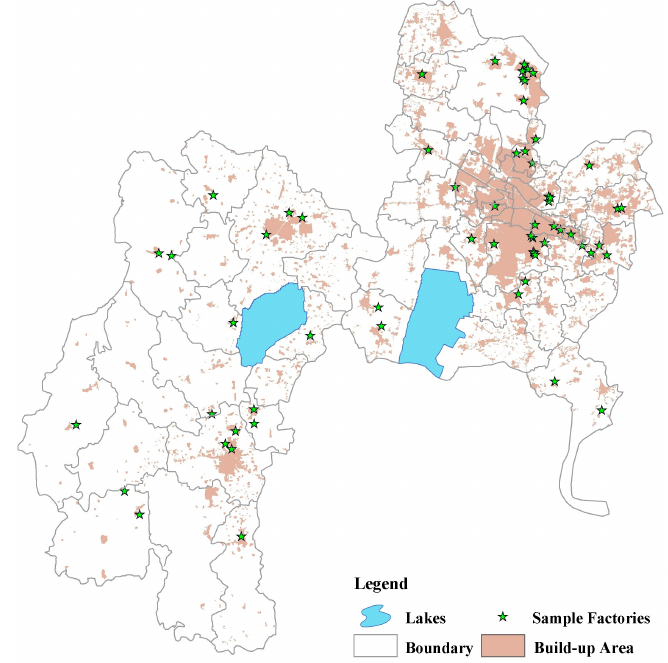
Figure 2. Monitoring points of sample enterprises.